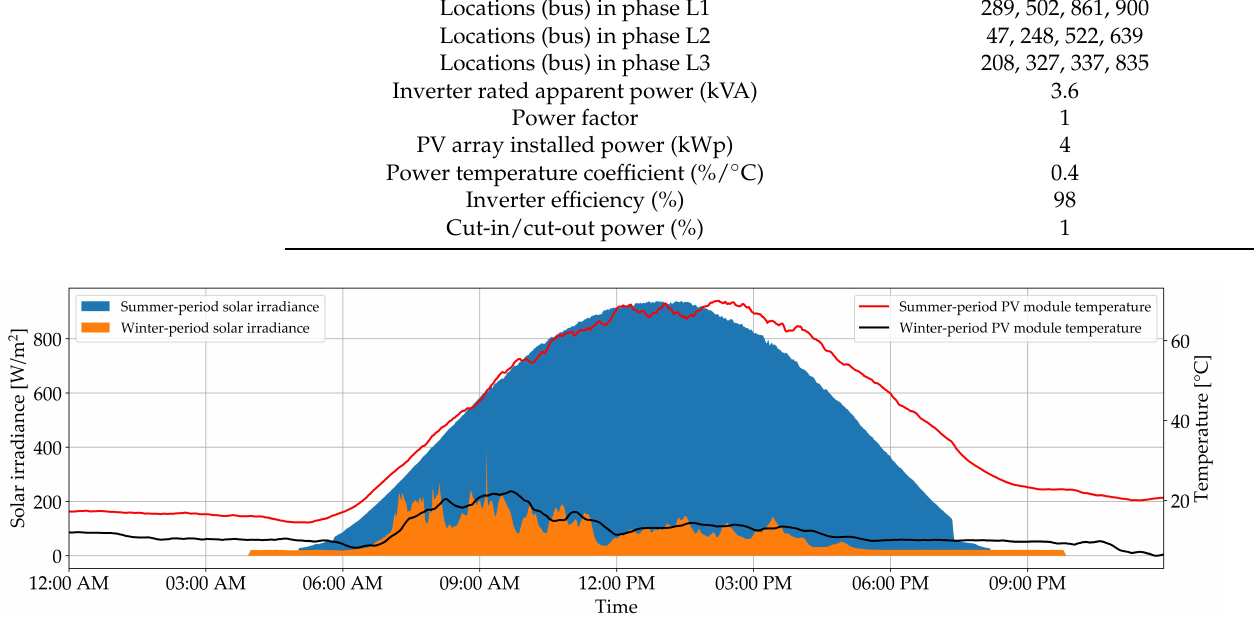
Figure 16. Solar irradiance and photovoltaic (PV) module temperature profile used for summer and winter